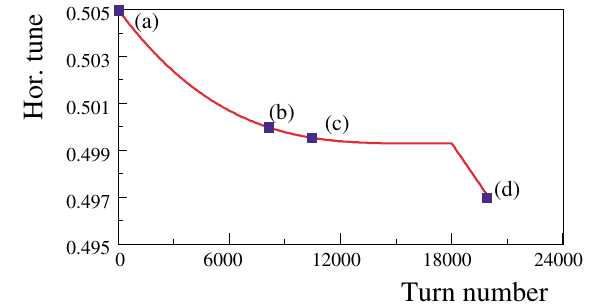
FIG. 1. (Color) Evolution of the tune used for the simulation of a two-turn extraction ( p (cid:1) 3 ). The four points labeled with letters correspond to the tune values at which the beam dis- tribution is shown in Fig. 2.